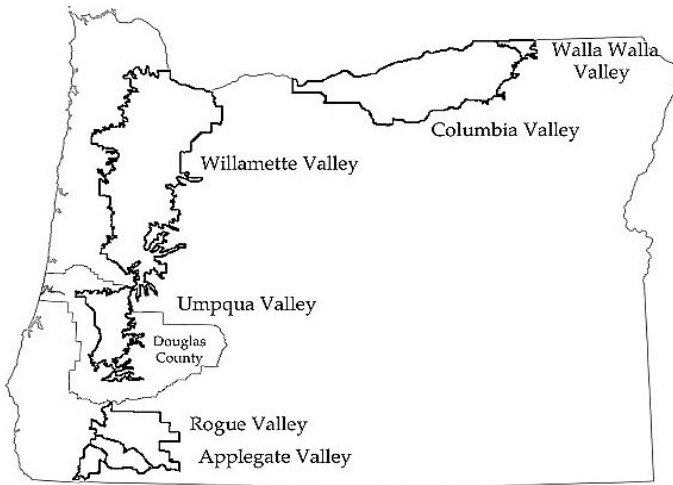
Figure 1. The spatial depiction of Oregon’s American Viticultural Areas (AVAs). (Adapted from [10], with permission from Jones, 2004).